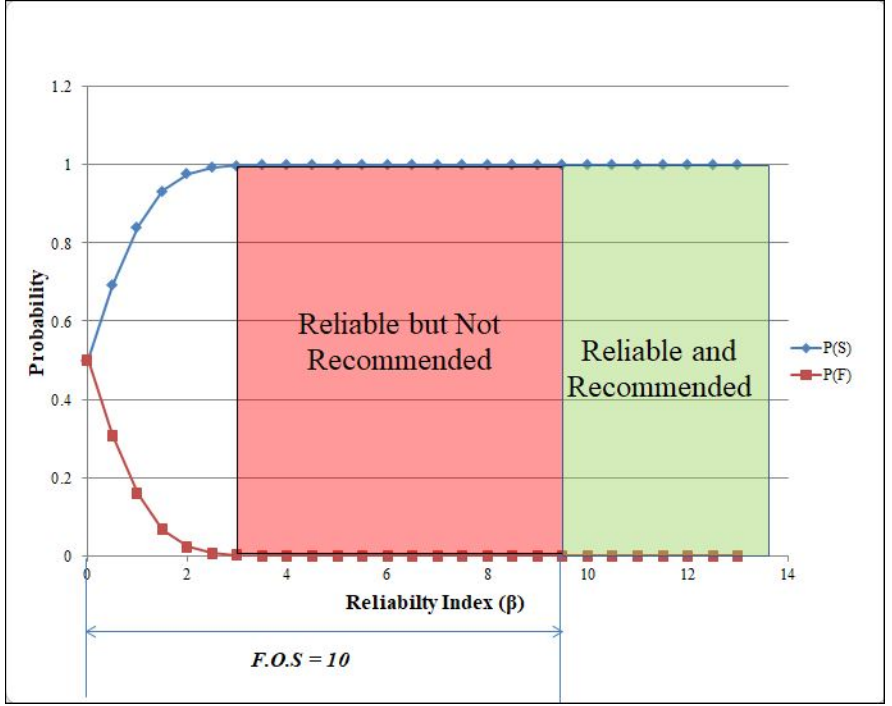
Figure 11. Reliability Index of MRCL.